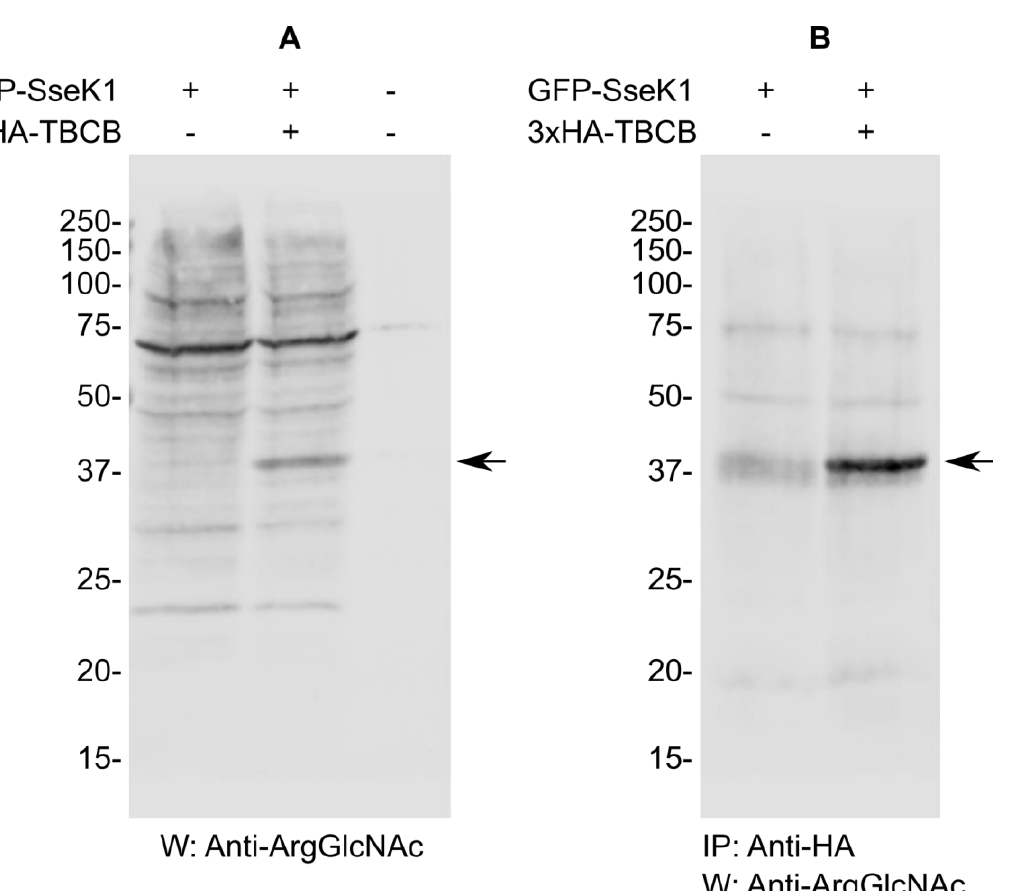
Figure 4. SseK1 glycosylates TBCB in vivo. ( A ) NP40 lysates from HEK293T cells transiently transfected with plasmids expressing GFP-SseK1 and/or 3xHA-TBCB, as indicated, were analyzed by immunoblot using anti-Arg-GlcNAc antibodies. ( B ) Lysates from HEK293T transiently transfected with a plasmid expressing GFP-SseK1 or with this plasmid and another plasmid expressing 3xHA- TBCB were subjected to immunoprecipitation (IP) with an anti-HA antibody. Precipitates were analyzed by western blot (W) with an anti-Arg-Glc-NAc antibody. Molecular weights in kDa are indicated on the left. The arrow indicates the band corresponding to